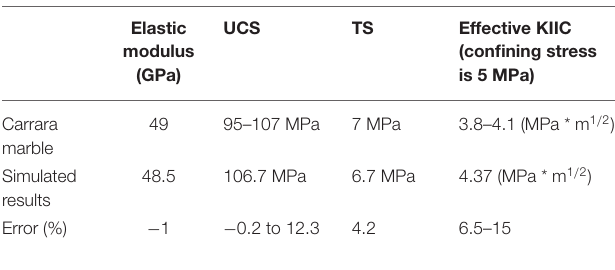
TABLE 1 | Mechanical